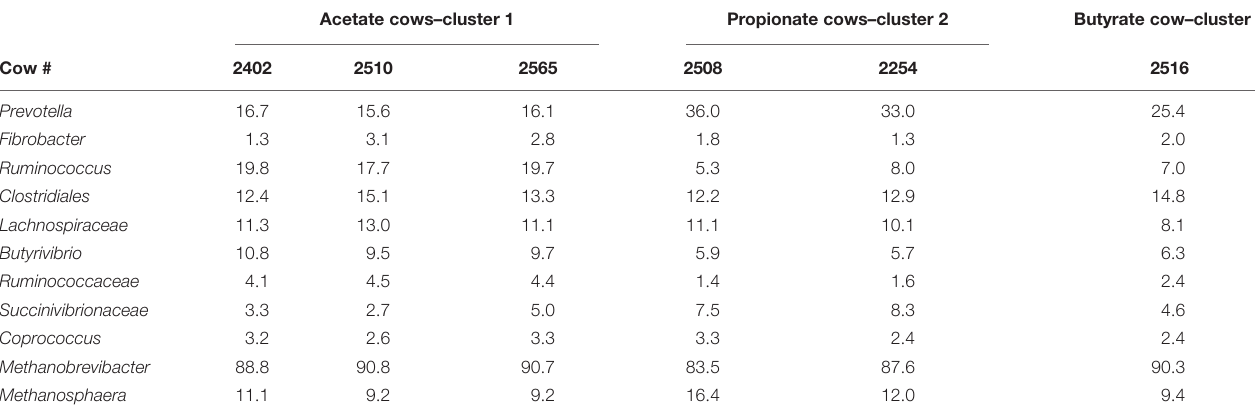
TABLE 1 | Relative abundance (%) of the most abundant cDNA-derived bacteria and archaea at the genus level in the rumen of cows identified within each cluster from cannula solid (CS) samples. Acetate cows–cluster